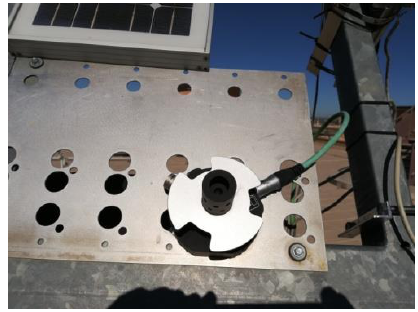
Figure 9. Controller. Figure 10. Tracking accuracy sensor.